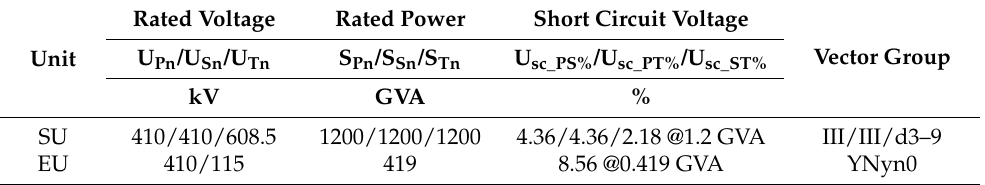
Table 2. Summarized serial unit (SU) and exciting unit (EU) calculated